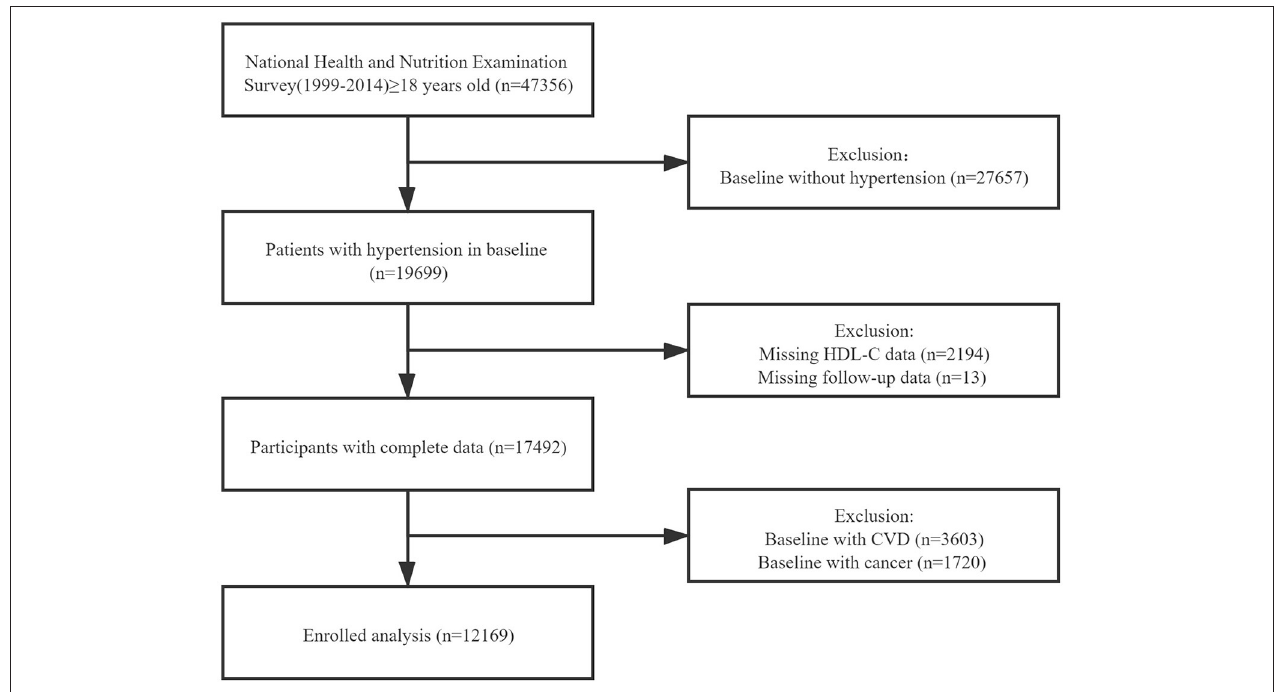
FIGURE 1 | The research flow